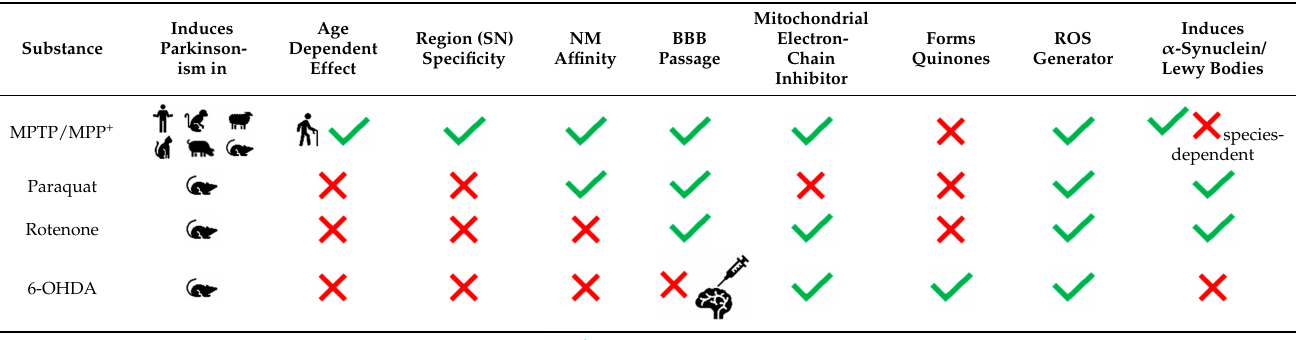
Table 1. Common PD-modeling chemicals and their mode of action (in